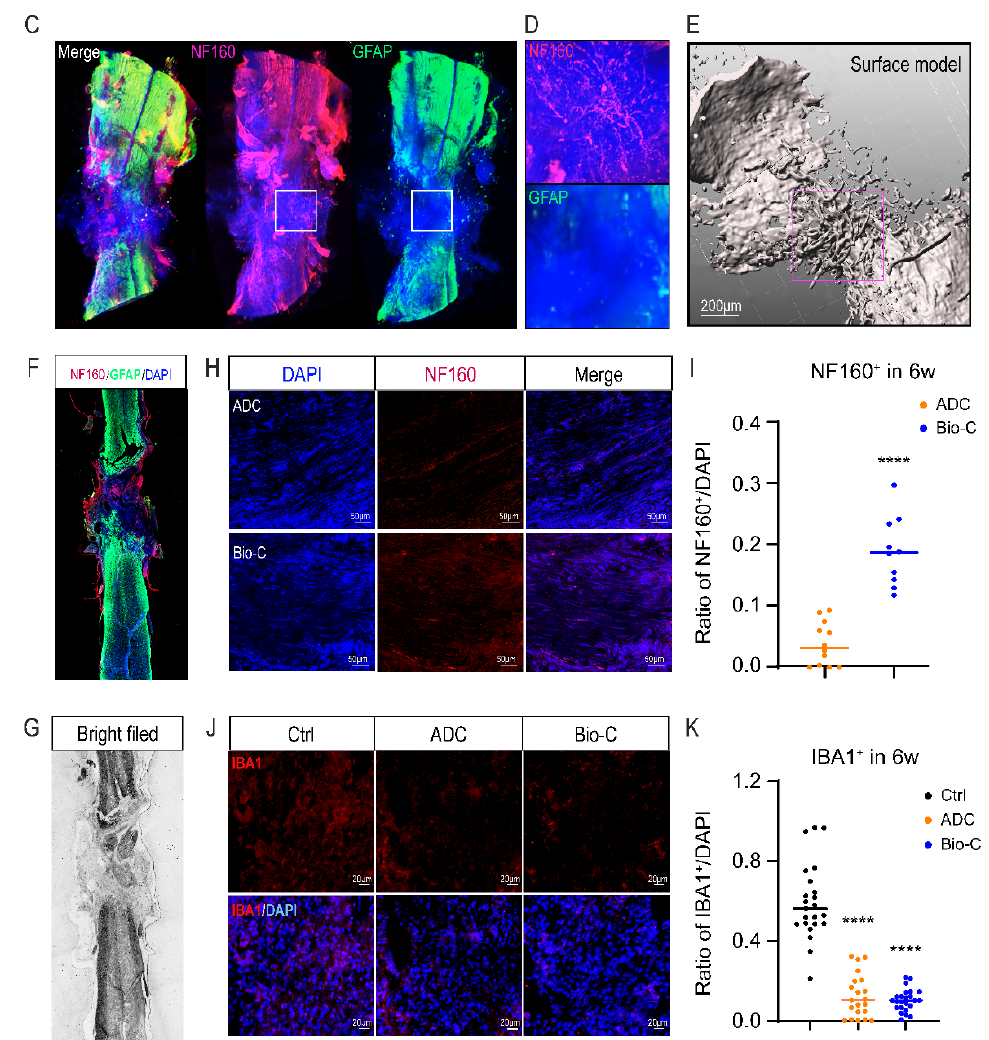
Figure 5. Bio-C increased NF160 + cell number and decreased IBA1 + cell number at 6 weeks after SCI. ( A ) Appearance of brain and spinal-cord tissues before and after CUBIC-clearing process. ( B ) Left: Bright field image showing spinal-cord tissue with Bio-C implants after clearing by using the CUBIC method. Right: a magnified image of the indicated area (the rectangle) in left. ( C ): The reconstituted 3D image showing distribution of NF160 + (red) and GFAP + (green) cells in Bio-C implants at 6 weeks after SCI. ( D ) Magnified images of the indicated area (rectangles) in ( C ), showing plenty of NF160 + and DAPI + but rarely GFAP + distribution in the lesion/regeneration area. ( E ) Three-dimensional surface reconstruction of NF160 + fiber from ( B ), using Imaris software. ( F ) Representative fields of NF160 and GFAP immunofluorescence staining of tissue sections from spinal-cord segments with Bio-C implants. ( G ) Bright field image of ( F ). ( H ) Representative fields of NF160 immunofluorescence staining in lesion area with ADC and Bio-C implants. ( I ) Quantitative analyses of immunofluorescence showing the ratio of NF160 + /DAPI + cells in ( H ) (mean ± SEM, n ≥ 3, **** p < 0.0001, comparing Bio-C group to ADC group). ( J ) Representative fields of IBA1 immunofluorescence staining in lesion/regeneration area in SCI/control, and SCI with ADC or Bio-C implants. ( K ) Quantitative analyses of immunofluorescence, showing the ratio of NF160 + /DAPI + cells in ( J ) (mean ± SEM, n ≥ 3, **** p < 0.0001, comparing Bio-C group and ADC group to injured control